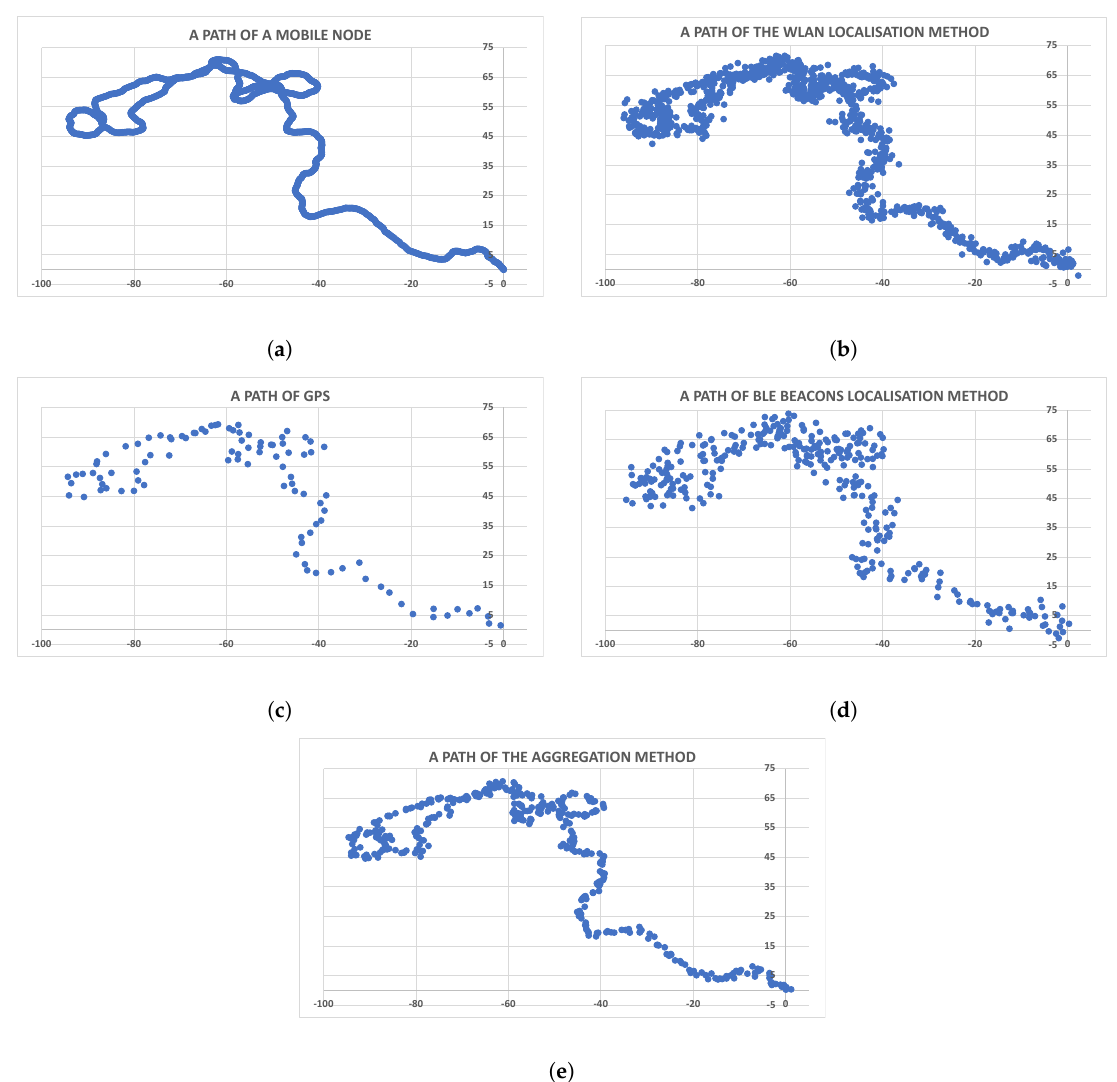
Figure 6. Exemplary path determined by the specific methods. ( a ) A real path of the mobile node (according to the Gauss–Markov mobility model). ( b ) A path appointed by a method based on WLAN. ( c ) Path appointed by GPS. ( d ) Path appointed by a method based on BLE beacons. ( e ) Path appointed by the localization-aggregation